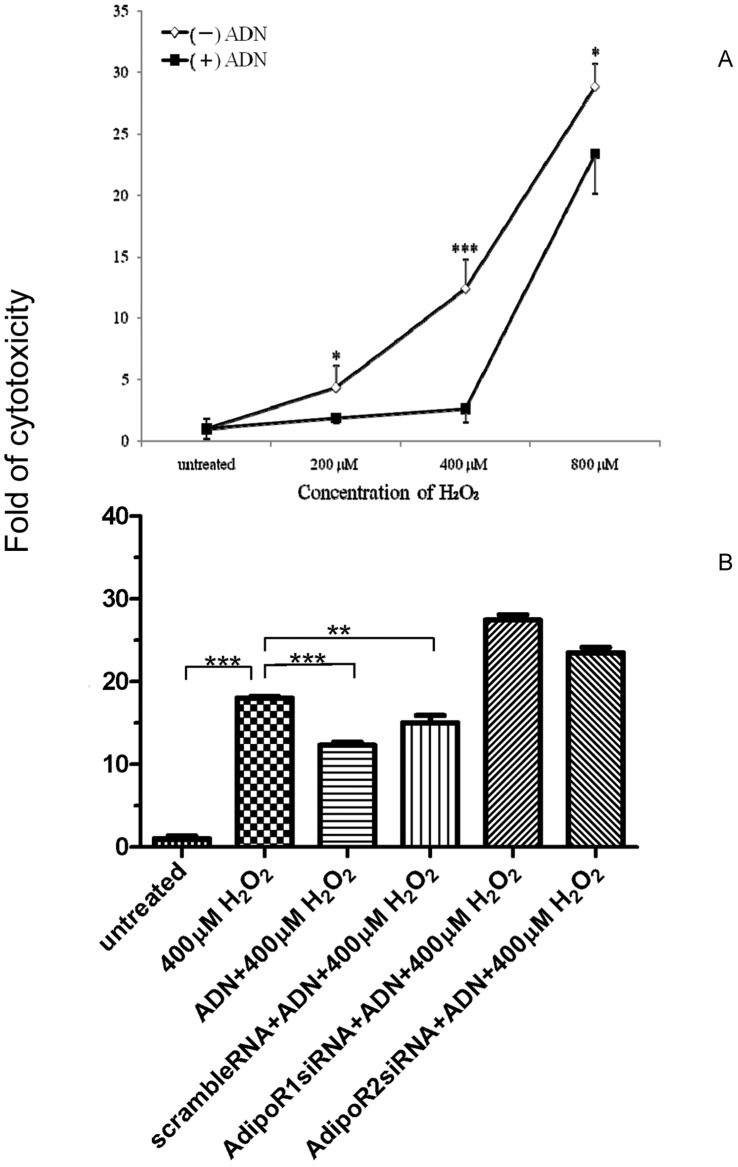
Adiponectin protection against cytotoxicity of SH-SY5Y cells transfected with Swedish-APP (Sw-APP) mutant under oxidative stress.(A) Percentage cytotoxicity of SH-SY5Y cells transfected with Sw-APP mutant under oxidase stress by different concentrations of hydrogen peroxide (H2O2) without and with pretreatment of adiponectin at 10 µg/ml expressed as fold of cytotoxicity relative to cytotoxicity without exposure to H2O2 (untreated, fold = 1) were shown on y-axis. In all three H2O2 concentrations, percentage cytotoxicity were significantly reduced with adiponectin pretreatment (p<0.05 for 200 µM H2O2, p<0.0001 for 400 µM H2O2 and p<0.05 for 800 µM H2O2). (−) ADN = without adiponectin pretreatment, (+) ADN = with adiponectin pretreatment. Results shown were mean values from 5 independent cultures, and compared by one-way ANOVA using Newman-Keuls multiple comparison test. (B) Using Sw-APP transfected SH-SY5Y cells with knockdown of AdipoR1 or AdipoR2 expression for the cytotoxicity experiments, it was observed that the protective effect of adiponectin against cytotoxicity under oxidative stress was preserved in control Sw-APP transfected SH-SY5Y cells without knockdown of AdipoR1 or AdipoR2 (scramble RNA+ADN+400 µM H2O2), but lost in cells with knockdown of AdipoR1 (AdipoR1 siRNA+ADN+400 µM H2O2) or AdipoR2 (AdipoR2 siRNA+ADN+400 µM H2O2) expression. This confirms that protective effect of adiponectin against cytotoxicity under oxidative stress in Sw-APP transfected SH-SY5Y cells required binding of adiponectin to its cell surface receptors AdipoR1 or AdipoR2. untreated = Sw-APP transfected SH-SY5Y cells without exposure to H2O2, 400 µM H2O2 = Sw-APP transfected SH-SY5Y cells exposed to 400 µM H2O2, ADN+400 µM H2O2 = Sw-APP transfected SH-SY5Y cells pretreated with adiponectin before exposure to 400 µM H2O2. Results shown were mean values from 3 independent cultures, and compared by one-way ANOVA using Newman-Keuls multiple comparison test.